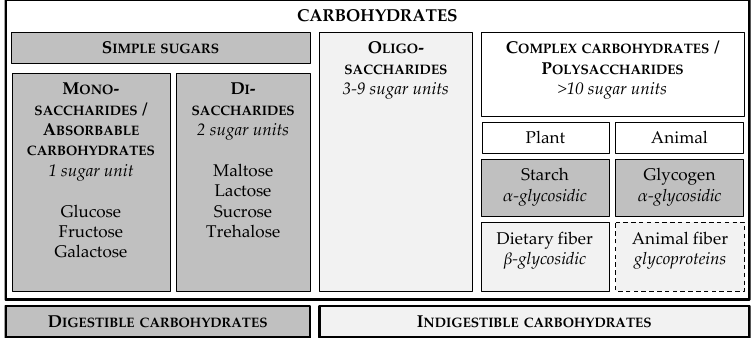
Figure 1. Classification of carbohydrates including simple sugars, oligosaccharides and complex carbohydrates. This literature review focusses especially on digestible carbohydrates, i.e., monosaccharides, disaccharides and starches.